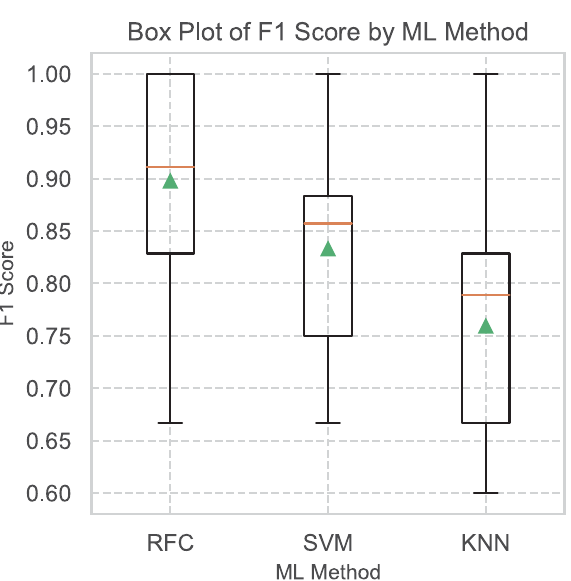
Figure 8. Box Plot of F1 Scores for each model, showing good equality of